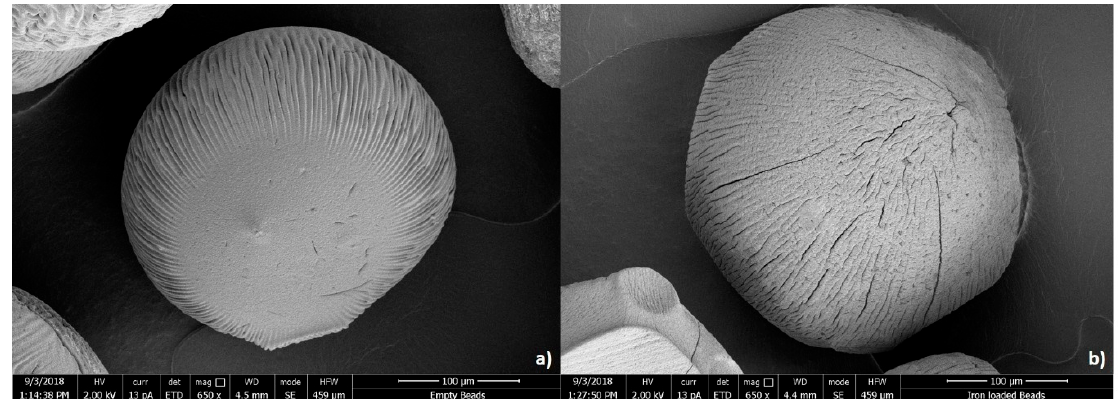
Figure 2. Scanning electron microscopy images of medium-sized ( a ) empty and ( b ) iron-loaded beads that were both air-dried before analysis and are thus smaller than their original size. The scale bar represents 100 µm.